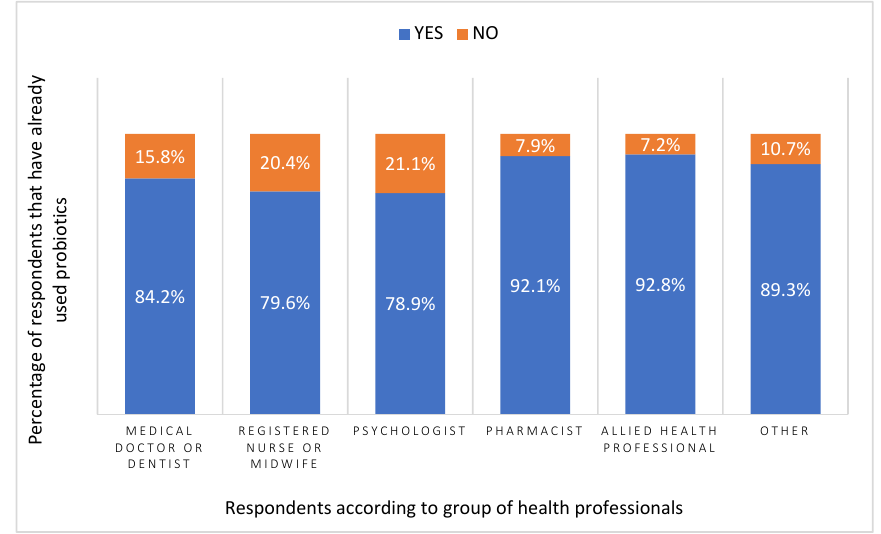
Figure 5. Use of probiotics among health professionals.